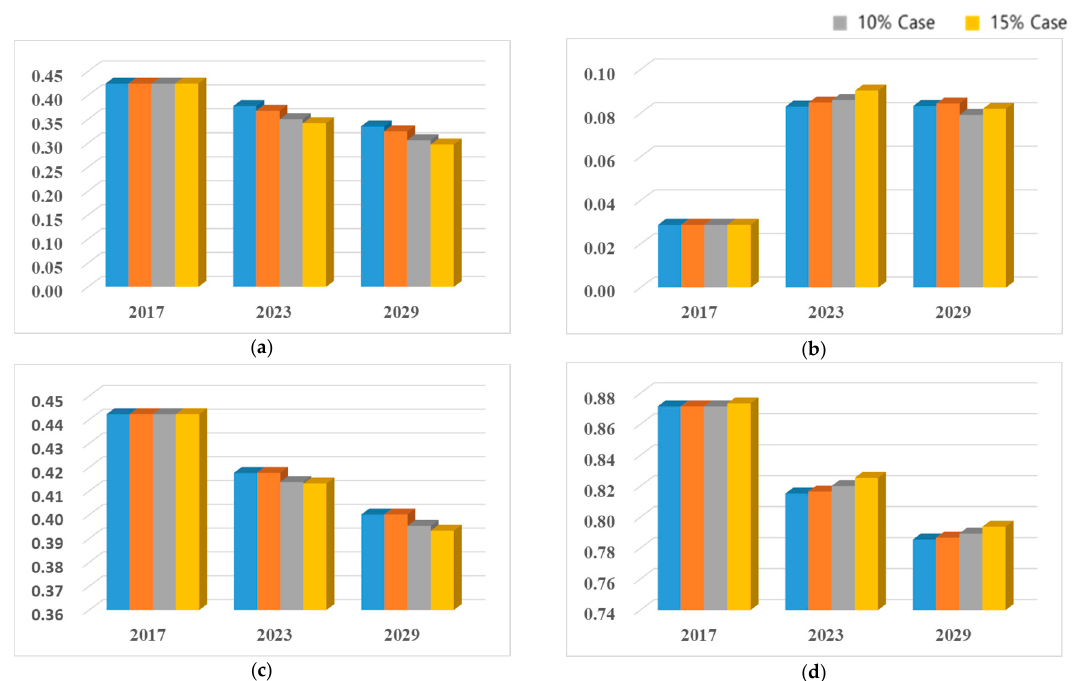
Figure 16. Changes in the emissions intensity (tCO 2 /MWh) with CER price increases in: ( a ) AP segment (M10); ( b ) IL segment (M1); ( c ) IF segment (M18); ( d ) RS segment (M5).